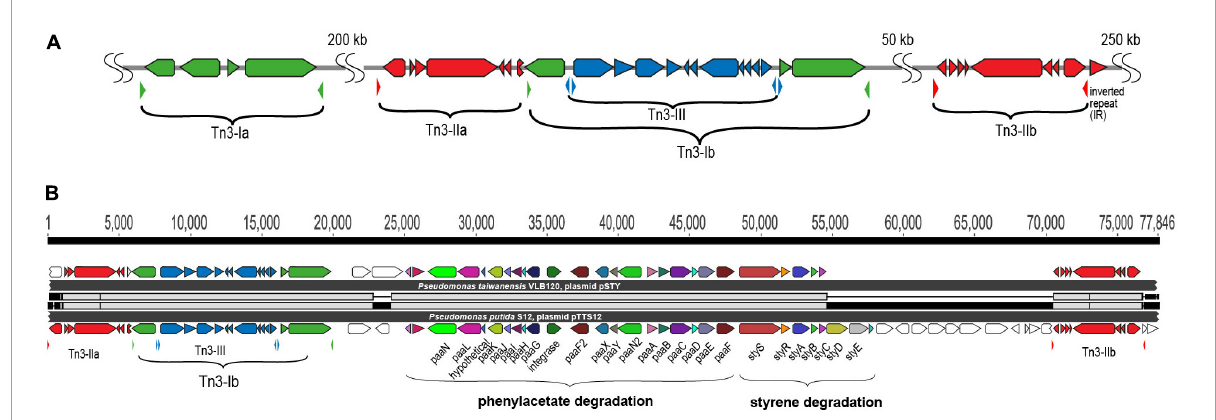
FIGURE3 Tn 3 transposon family elements responsible for horizontal gene transfer of styrene and phenylacetate degradation pathway. (A) Genetic organization of the three different Tn 3 -family transposable elements in pTTS12. Colors represent the three different Tn 3 transposon families; Tn 3-I with highest identity to Tn 4656 (green), Tn 3-IIa and b with highest identity to Tn 5053 (red) and Tn 3-III with highest identity to Tn 5563 (blue). The inverted repeats (IRs) flanking each element are marked by small, lowered triangles in the same colors, accordingly. (B) Alignment of the Tn 3 -mediated horizontal gene transfer of the styrene and phenylacetate degradation cluster in pTTS12 (bottom) and pSTY from Pseudomonas taiwanensis VLB120 (top). Colors represent the different genes constituting styrene-phenylacetate degradation cluster and the three Tn 3 transposable elements, corresponding to the color-coding in panel A. Gene names are